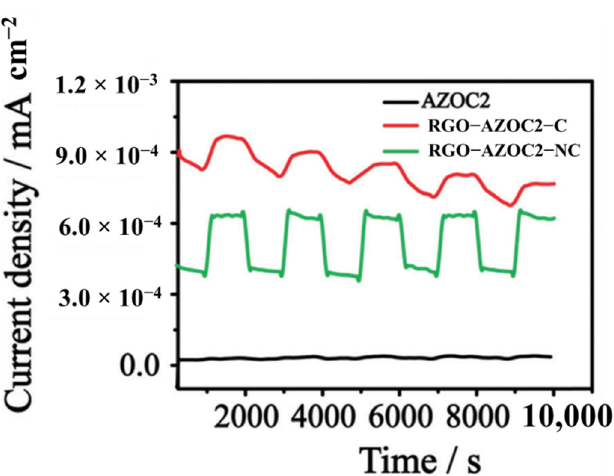
Figure 27. Photocurrent measurement of AZOC2, RGO–AZOC2-C, and RGO–AZOC2-NC as a func-